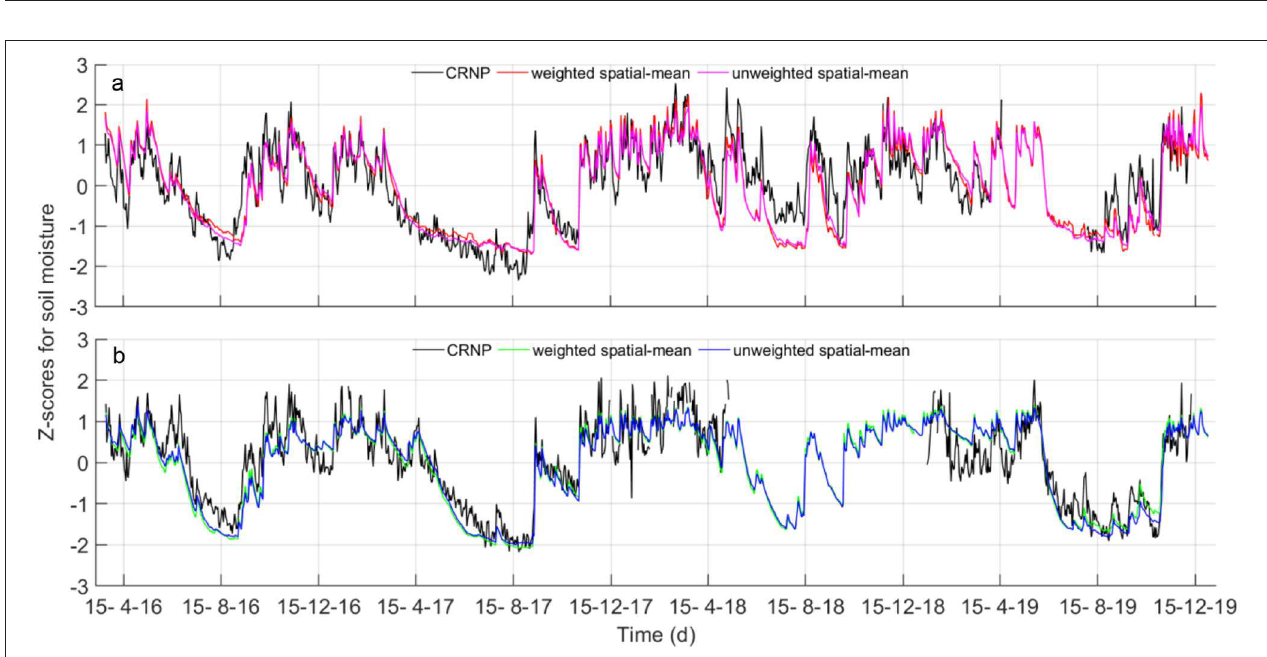
FIGURE 6 | Daily values of Z -scores of unweighted spatial-mean SoilNet-based soil moisture contents, weighted spatial-mean and CRNP-based soil moisture (black line) in (a) MFC2; and (b) GOR1.